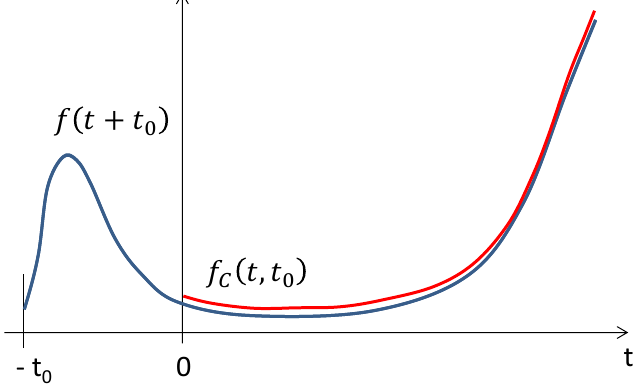
Figure 2. Conditional failure probability density of a used component.